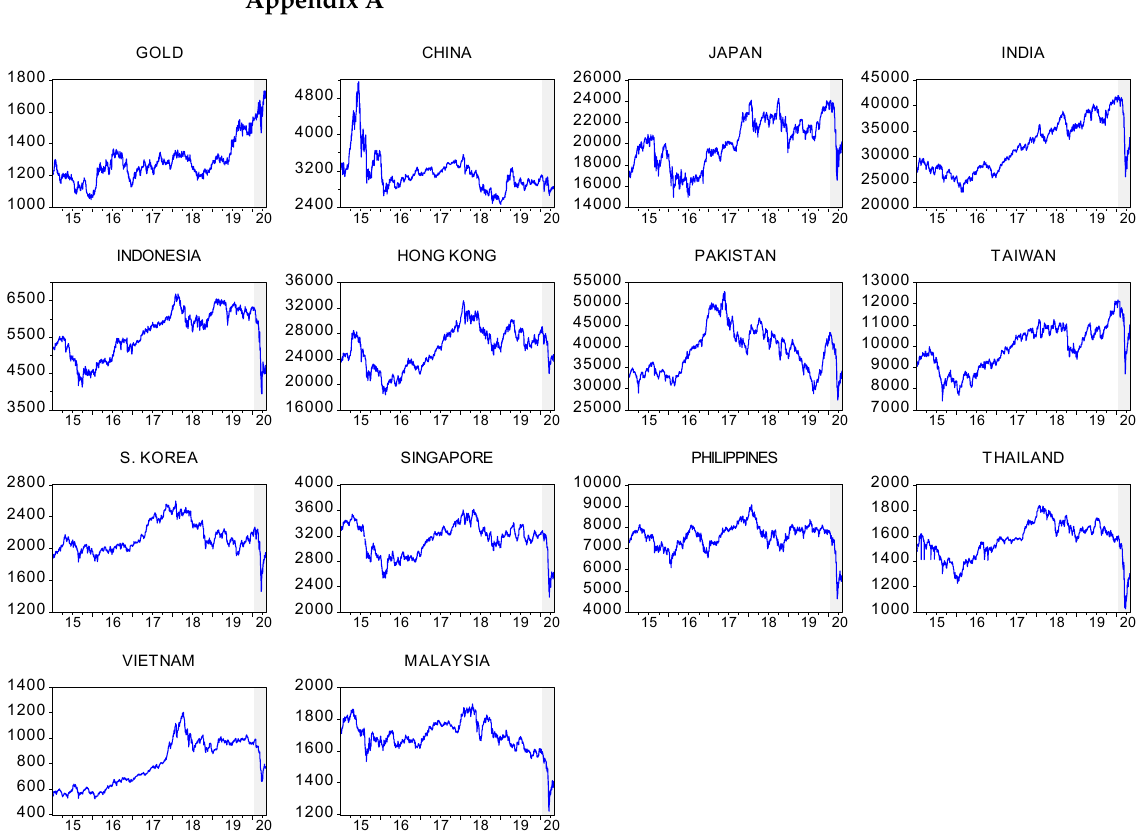
Figure A1. Prices of gold and Asian stock market indices.